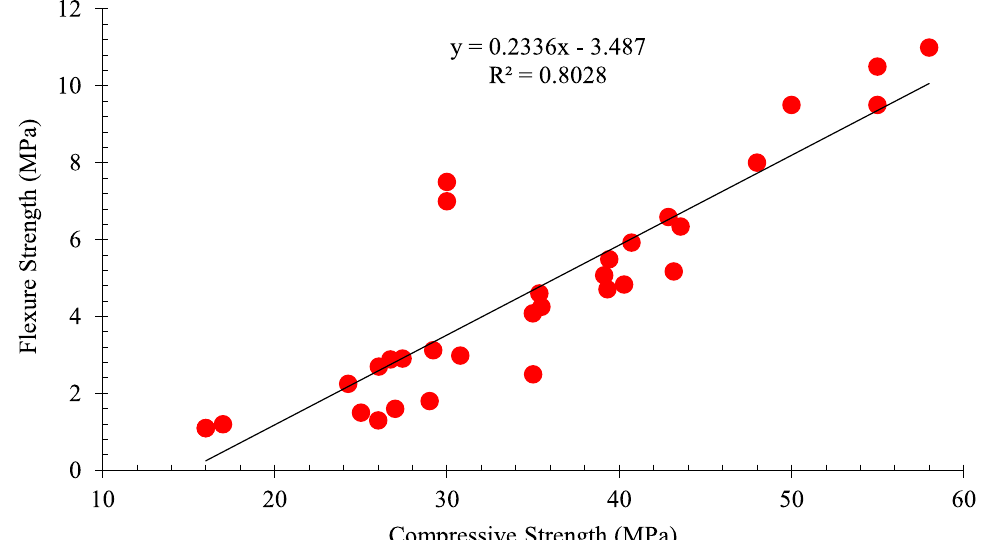
Fig. 13 Correlation between compressive strength and flexural strength (Latha et al., 2015; Ofuyatan et al., 2022; Rahman et al., 2019; Topcu et al.,